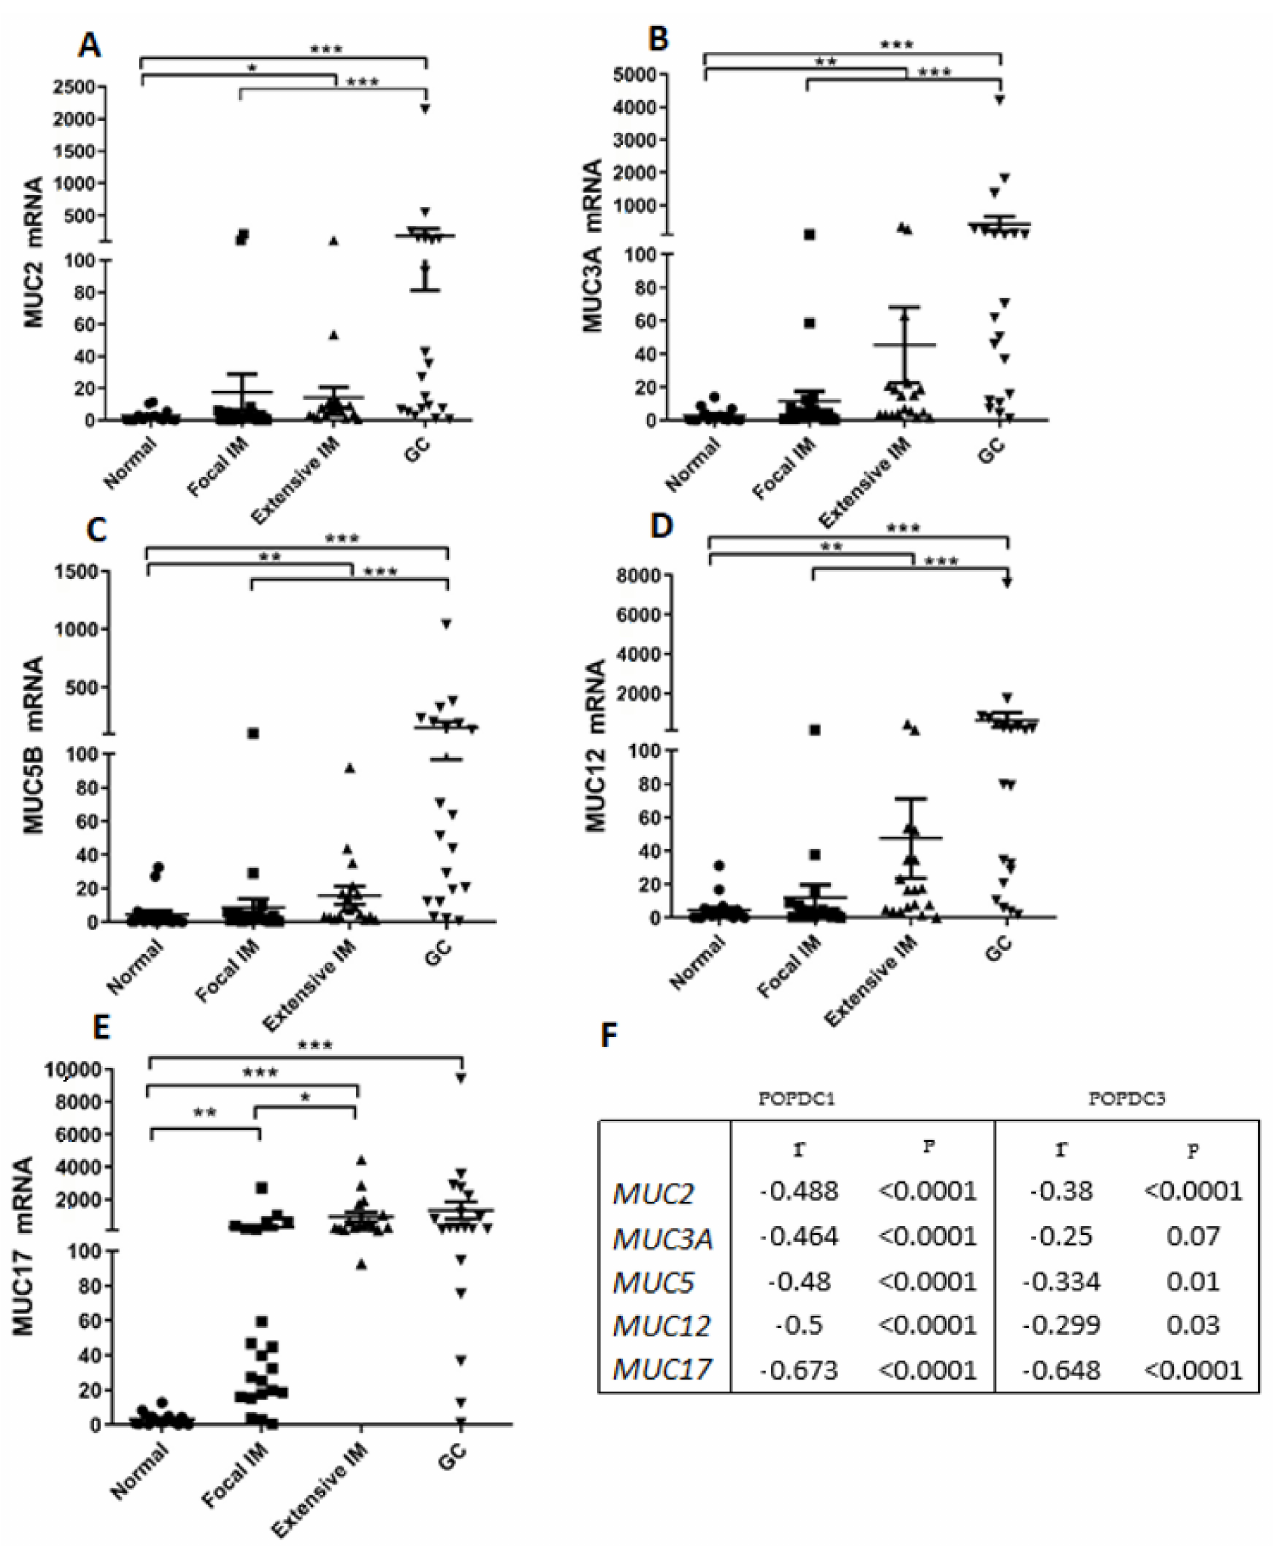
Figure 6. Expression levels of mucin genes and correlation with POPDC1 and POPDC3 expression ( A–E ). Summary of mucin transcript quantification. MUC , mucin. * p < 0.05; ** p < 0.005; *** p < 0.0001. Mean ± SEM. ( F )Results of Spearman’s correlation test between the transcript levels of each mucin and POPDC1 and POPDC3